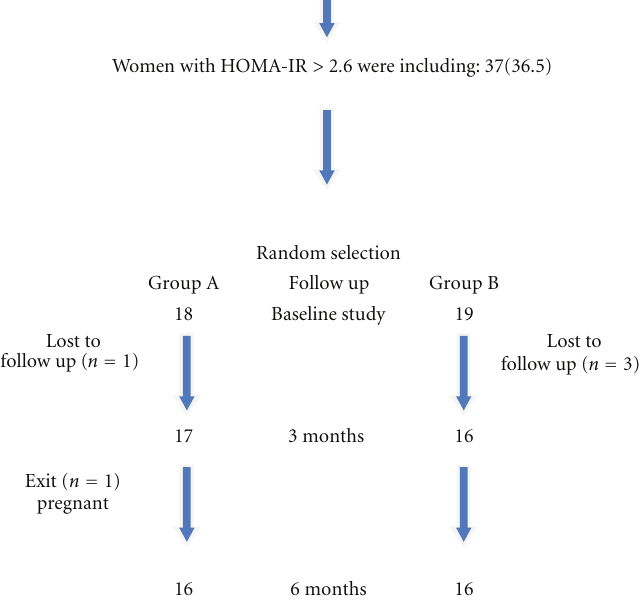
Women with HOMA-IR > 2 . 6 were including: 37(36.5)